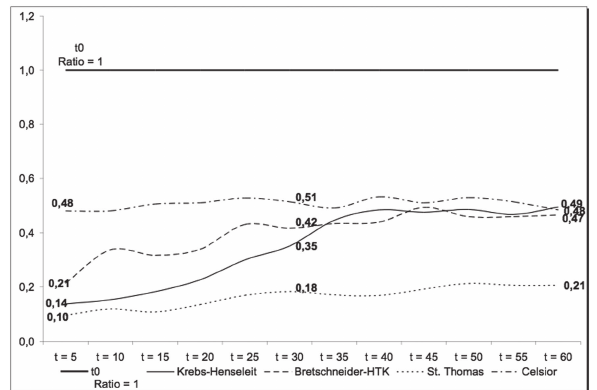
treatmentFig. 2 - Left ventricle systolic pressure (LVSP) according to the solution. Reperfused hearts were monitored for 60 min with the following solutions: Krebs-Henseleit Buffer, Bretschneider-HTK, St. Thomas No. 1, and Celsior. Baseline was calculated after stabilization and prior to